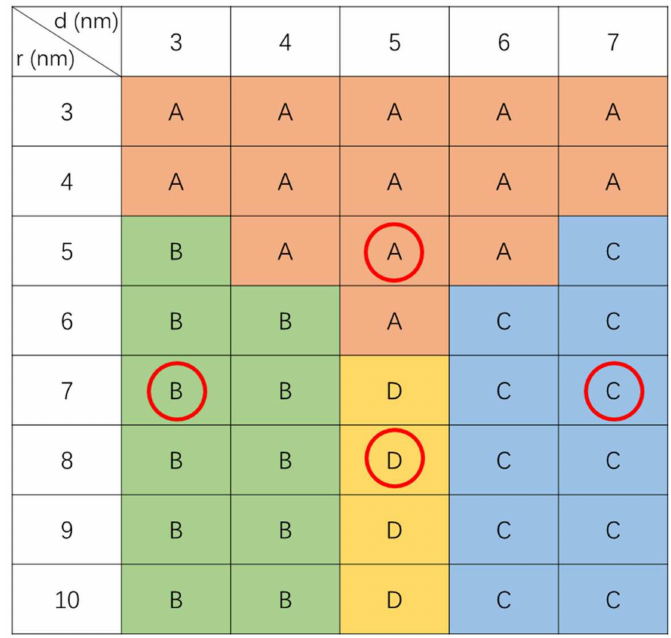
Figure 3. The switching type diagram of FePt/Fe core-shelled structure as a function of the thickness of the iron shell and the radius of FePt core. d and r in the figure represents the thickness of iron shell in the range of 3–7 nm and the radius of FePt core in the range of 3–10 nm, respectively. The the switching type A, B, C, and D of the core-shelled FePt/Fe structure in Figure 2,